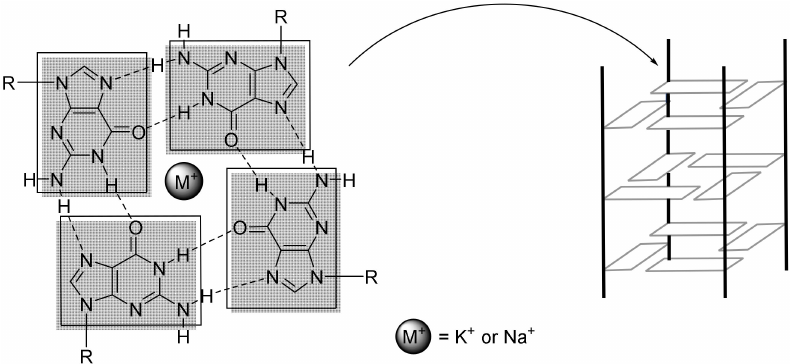
Figure 1. Structure of a G-tetrad and simplified schematic representation of a